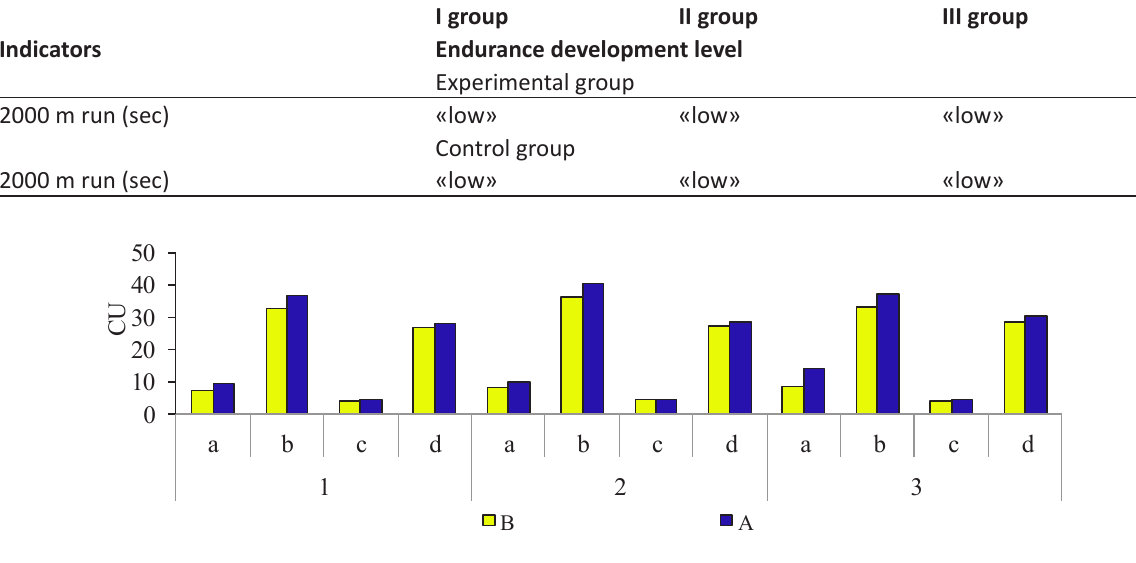
Fig. 1. Indicators of strength development level of girl-students of the experimental groups before and after the experiment: a – pressing ups in lying position (quantity of times); b – torso rising from lying position into sitting one (quantity of times); c – 3 single leg jumps (m); d – hand dynamometry (kg); CU – conventional units; B – before the experiment; A – after the experiment; 1, 2, 3 – numbers of groups.